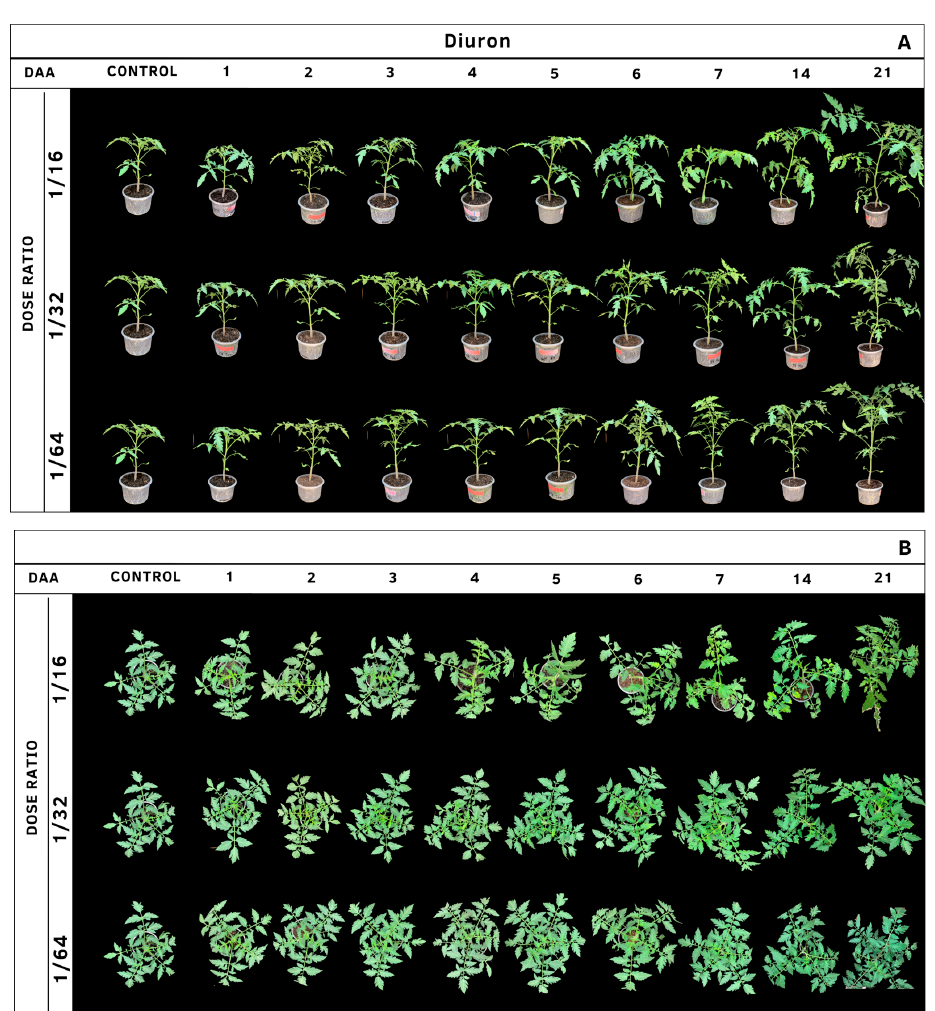
Figure 12. The e ff ects of simulated hexazinone drift with a close-up view show injuries in tomato plants.